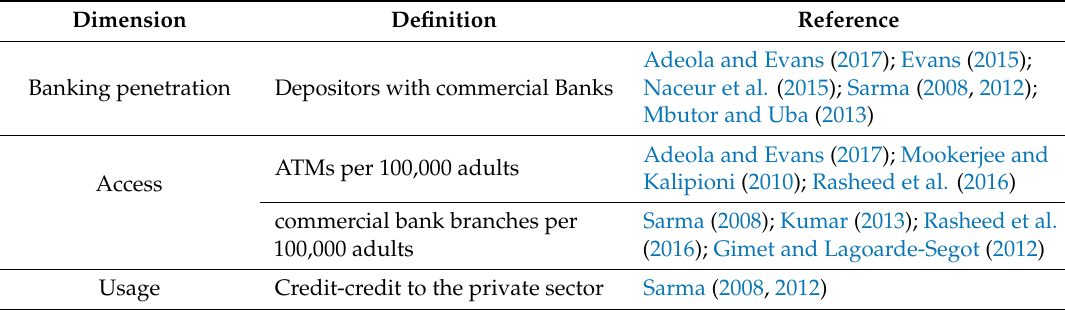
Table A2. Financial inclusion proxy